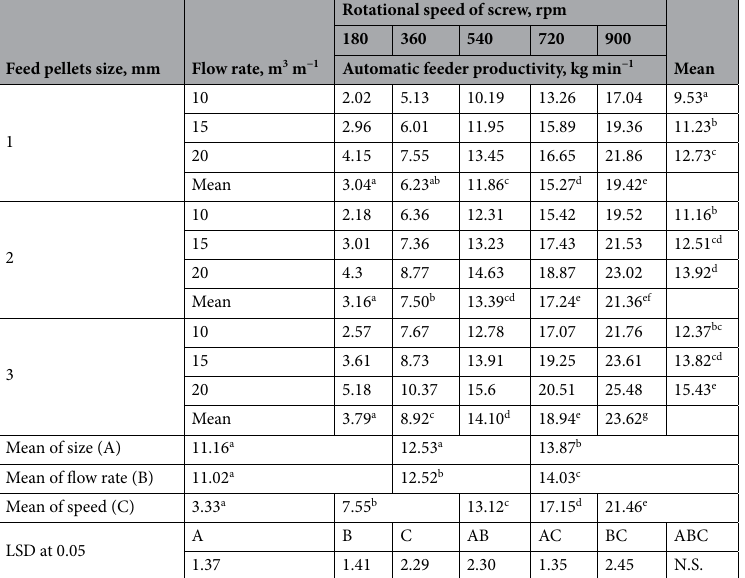
Feed pellets size, mm